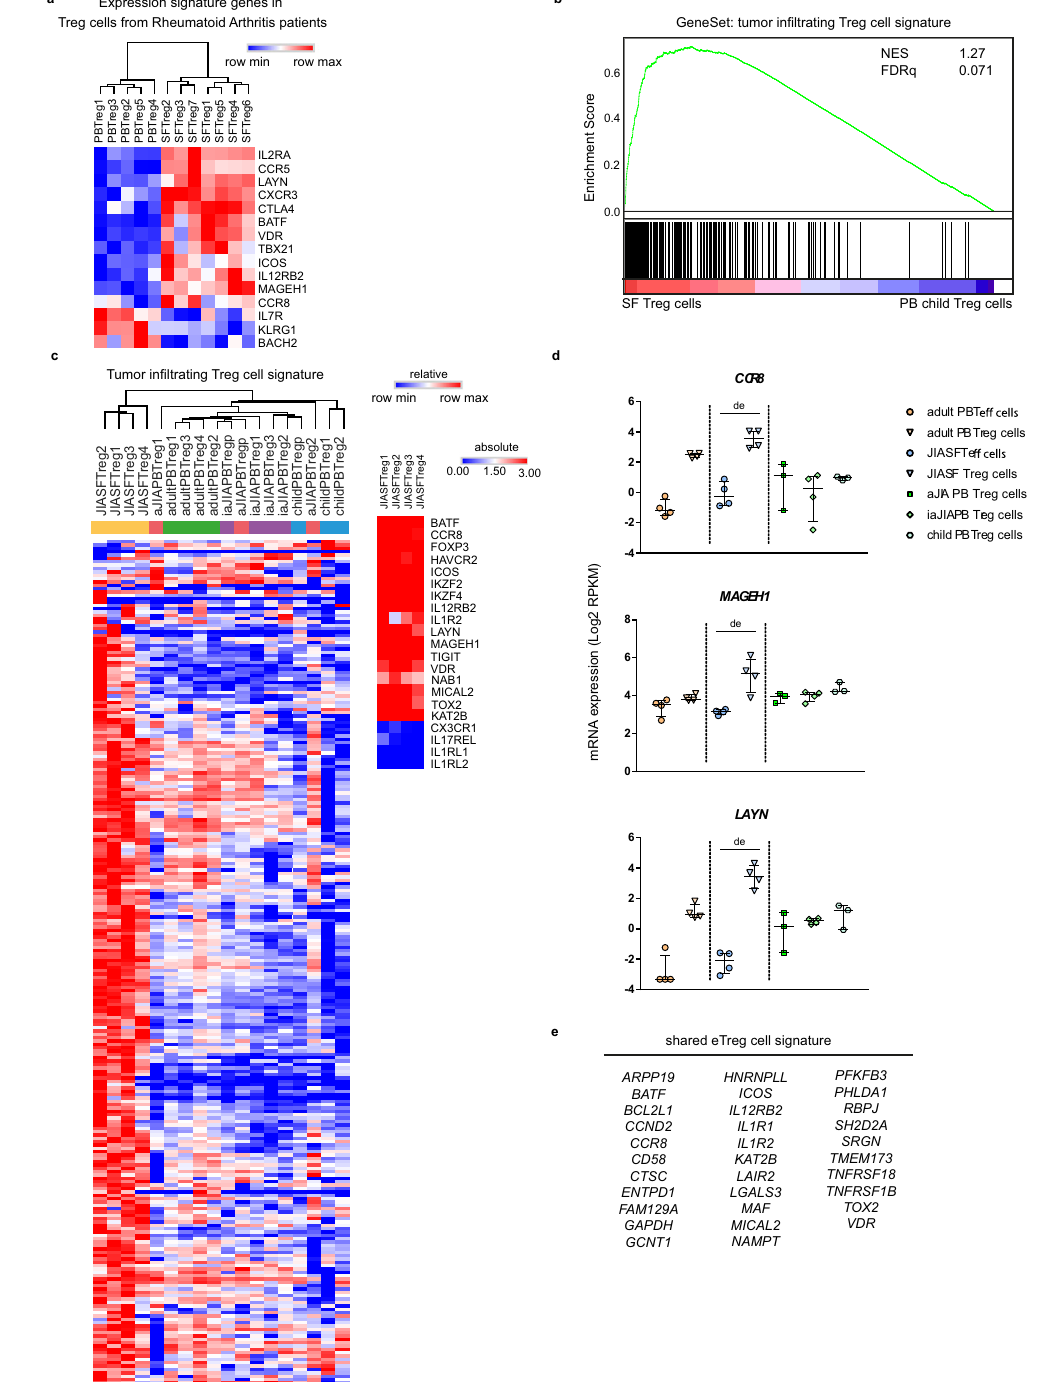
OKT3, 1:400), CD25-PE/Cy7 (clone M-A251, 1:25; BD), CD127-AF647 (clone HCD127, 1:50; Biolegend), CD4-FITC (clone RPA-T4, 1:200; eBioscience). To check for FOXP3 expression of the sorted populations cells were fi xed and per- meabilized by using eBioscience Fixation and Permeabilization buffers (Invitrogen) and stained with anti-human FOXP3-eF450 (clone PCH101, 1:50; eBioscience) (see Supplementary Fig. 1b). Read out of proliferation is performed with the following antibodies: CD3-PerCP/Cy5.5 (clone UCHT1, 1:100; Biolegend), CD4-FITC